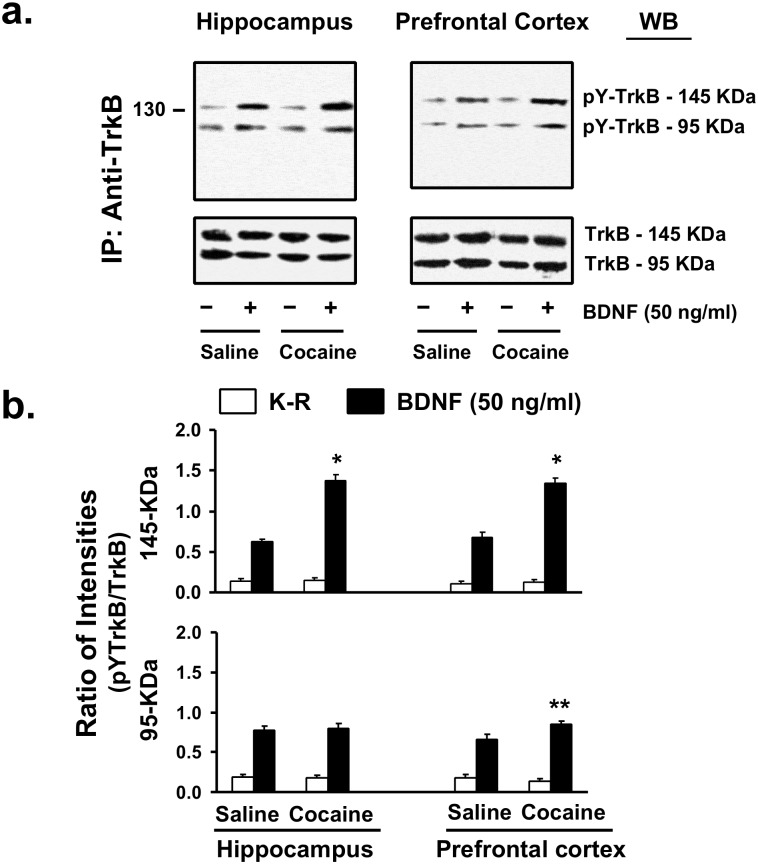
Prenatal cocaine exposure increased 50 ng/ml BDNF-induced TrkB activation in hippocampi and PFCX.(a) Representative blots showing prenatal cocaine exposure increased 50 ng/ml BDNF-induced TrkB activation in hippocampi and PFCX evidenced by higher activated (tyrosine-phosphorylated [pY]) TrkB. (b) Summary of the densitometric quantification of the pY and total 145- and 95-KDa TrkB. The data are expressed as the ratios of pY- full-length (145-KDa) and truncated TrkB (95-KDa) optical intensity normalized by the optical intensity of total 145- and 95-KDaTrkB, respectively. n = 6 (3 females and 3 males). Data are reported as means ± s.e.m. of the ratio of pY-TrkB to TrkB optical intensities. *p < 0.01, **p < 0.05 compared to respective protein in the saline-treated group.